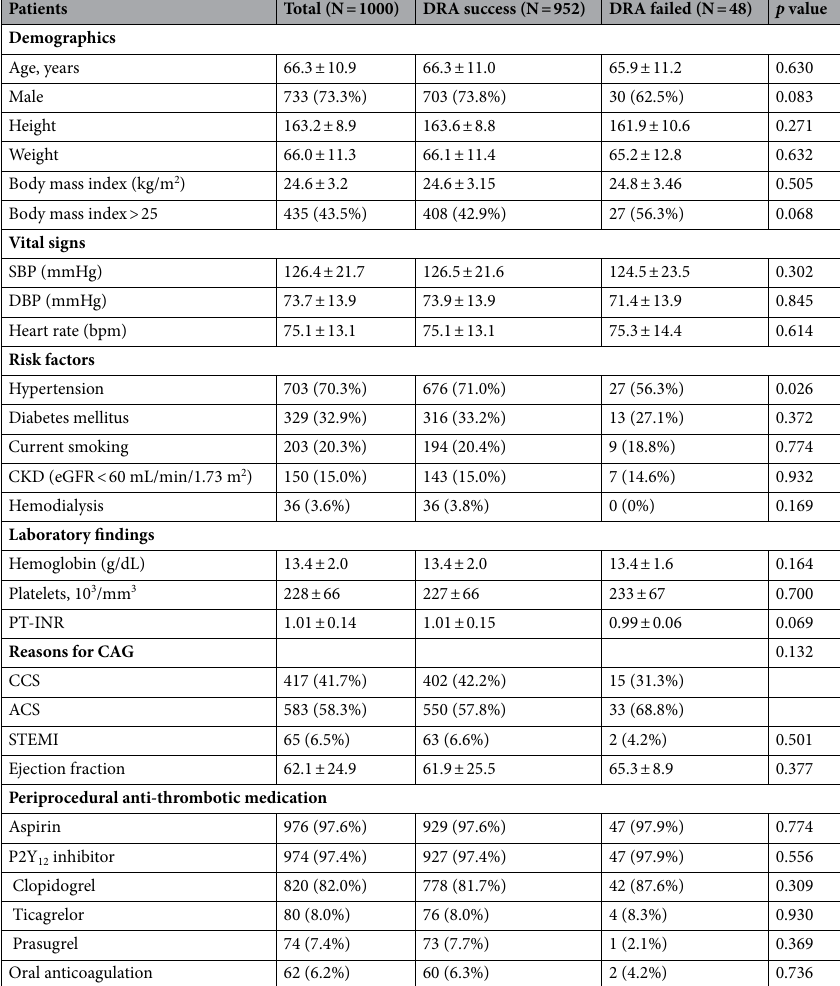
Table 2. Baseline clinical characteristics of the study population. Values are presented as mean ± standard deviation, numbers (%). SBP Systolic blood pressure, DBP Diastolic blood pressure, CKD Chronic kidney disease, eGFR Estimated glomerular filtration rate, PT-INR Prothrombin time-international normalized ratio, CAG Coronary angiography, CCS Chronic coronary syndrome, ACS Acute coronary syndrome, STEMI ST-elevation myocardial infarction.